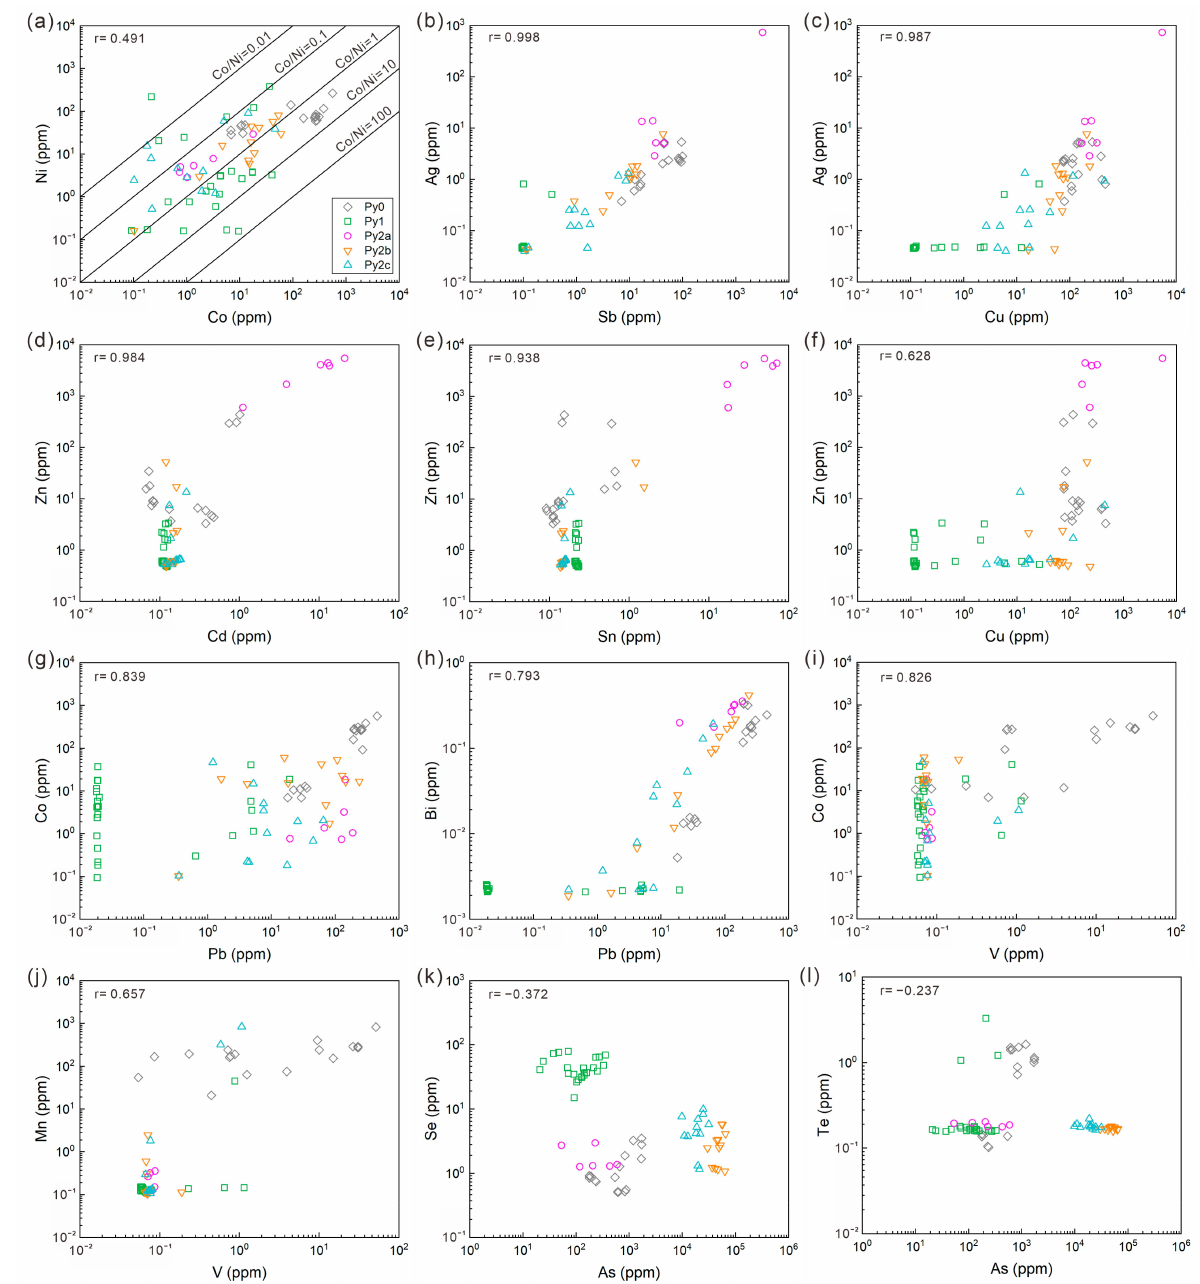
Figure 11. Elemental binary plots and correlations for different types of pyrite from the Dunbasitao gold